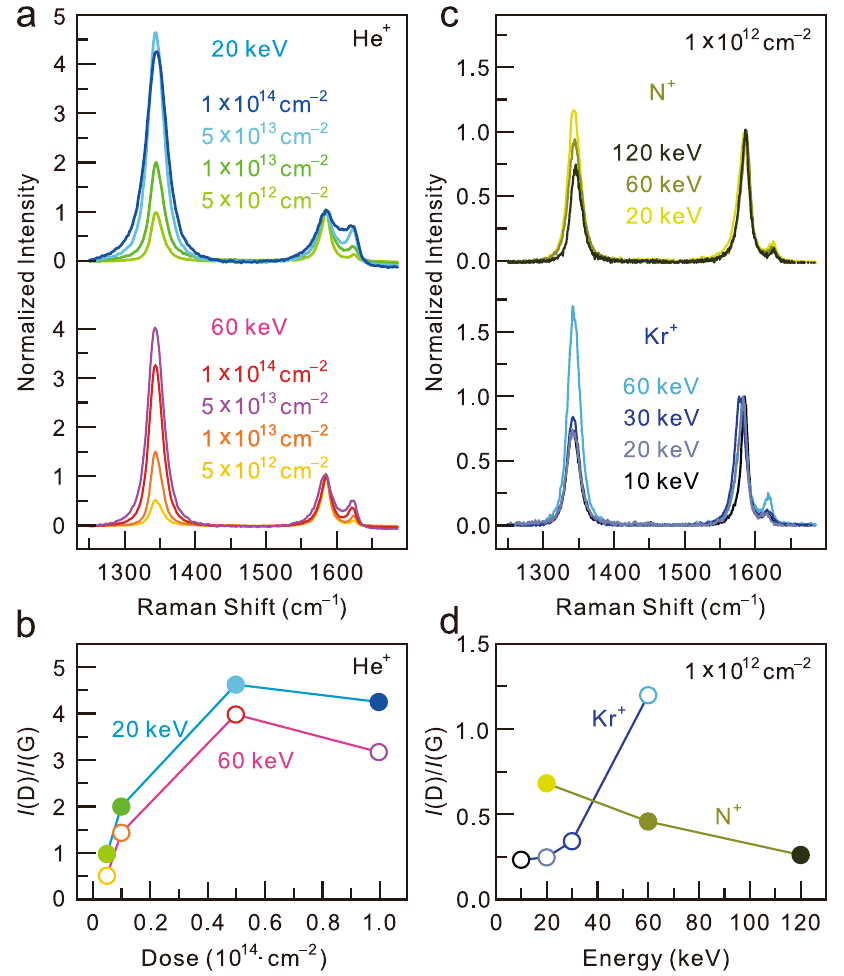
Figure 1. ( a ) Raman spectra of graphene obtained after He + ion irradiation for various doses (5 × 10 12 , 1 × 10 13 , 5 × 10 13 and 1 × 10 14 ions/cm 2 ) at energies of 20 (top) and 60 (bottom) keV. ( b ) I (D)/ I (G) for He + ion irradiation as a function of dose. ( c ) Raman spectra of graphene after N + (top) and Kr + ion irradiation (bottom) for various energies. ( d ) I (D)/ I (G) for N + and Kr + ion irradiation as a function of